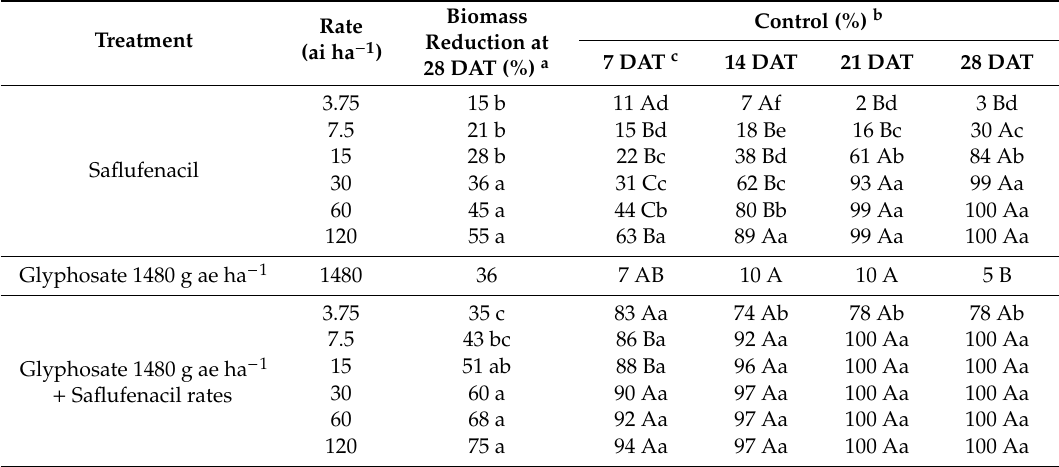
Table 2. Estimated biomass reduction (% compared with untreated plants) and control (%) of glyphosate-resistant Conyza bonariensis in response to herbicide treatment using the regression models.